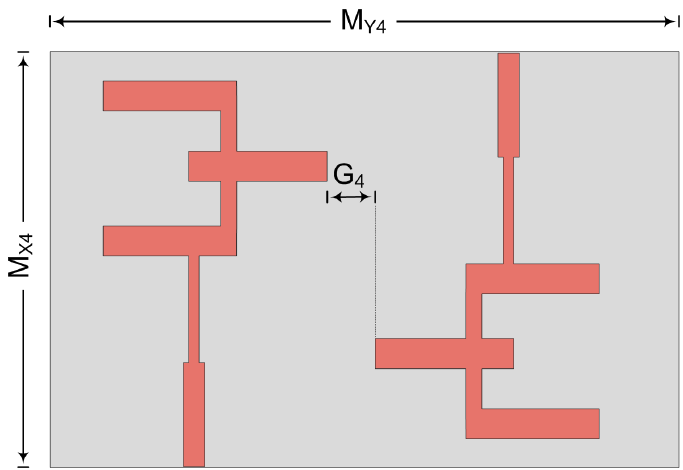
Figure 15. Schematic of MIMO antenna for opposite elements. Figure 14. Comparison among gain and numerically calculated radiation efficiency of MIMO antenna with orthogonal placement of element.